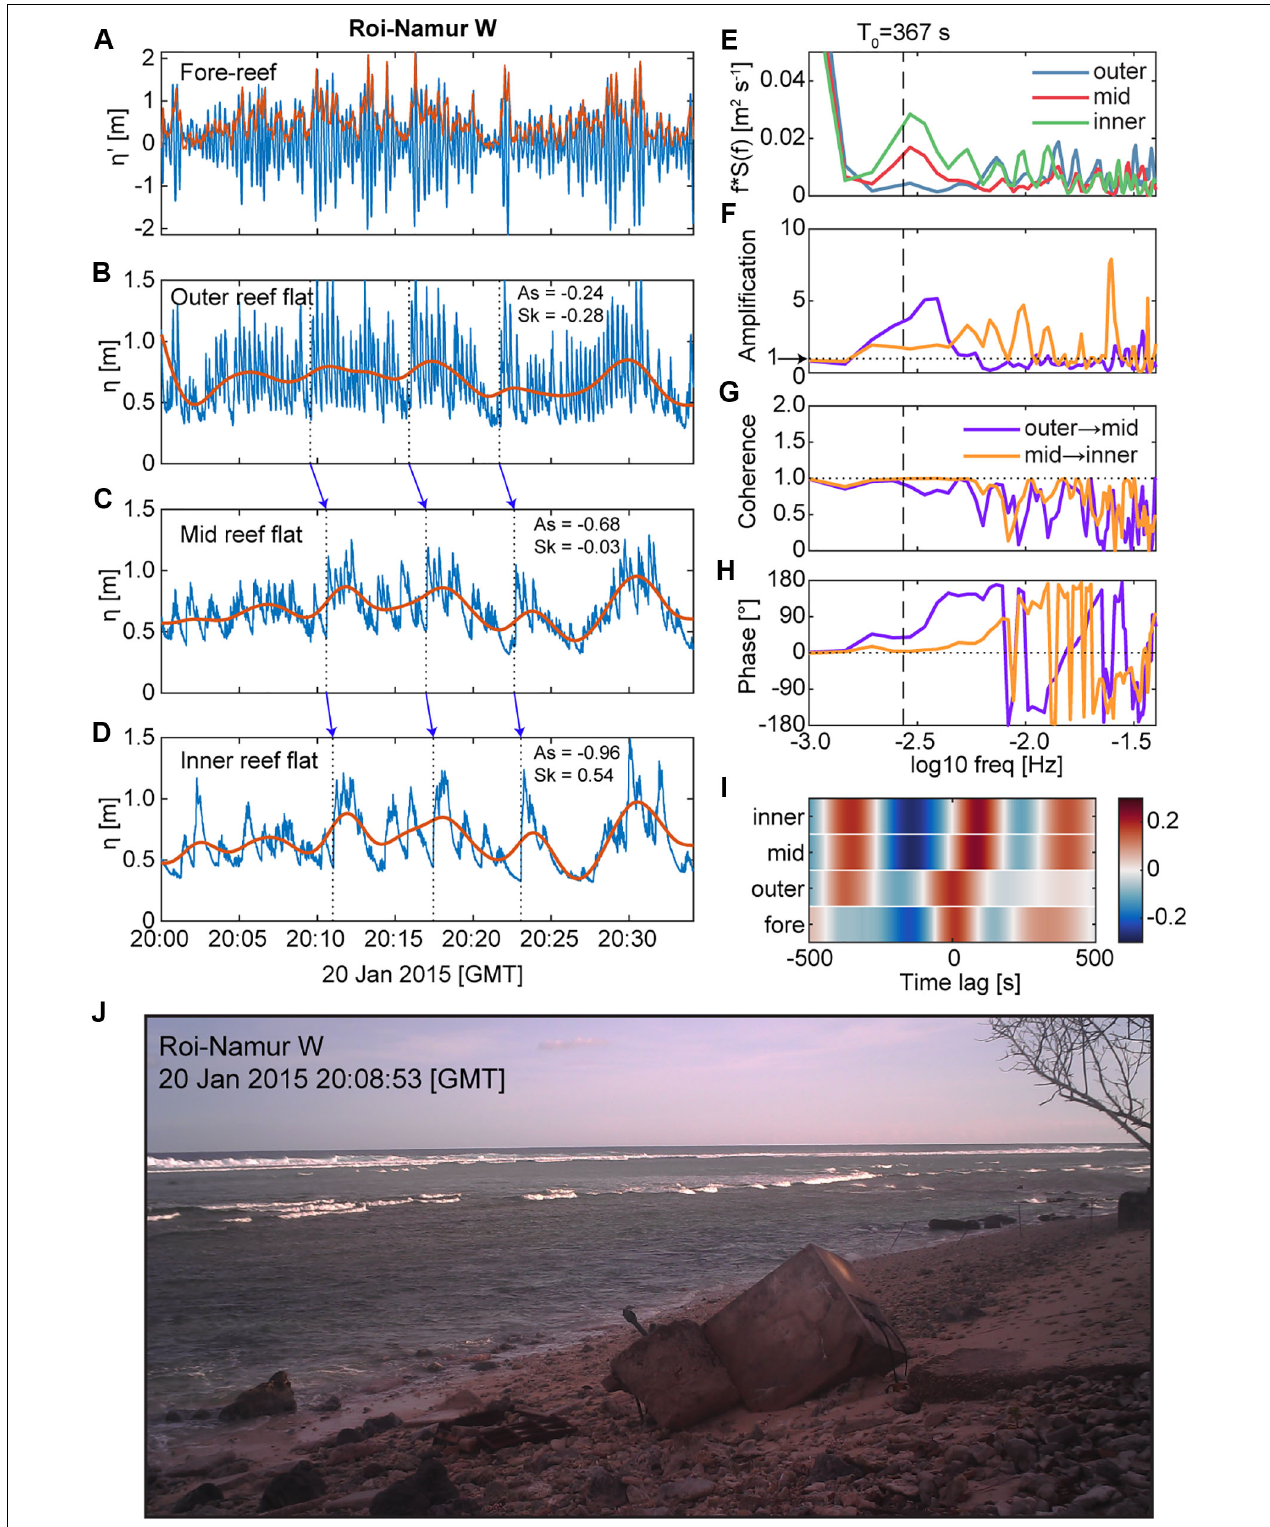
FIGURE 7 | An example of how large very-low frequency (“VLF”) motions can facilitate the growth of large infragravity (“IG”) bores on reef flats, using observations from Roi-Namur W during a large offshore wave event on 20 January 2015. (A) Fore-reef water levels relative to the mean (blue) with the sea-swell (“SS”)